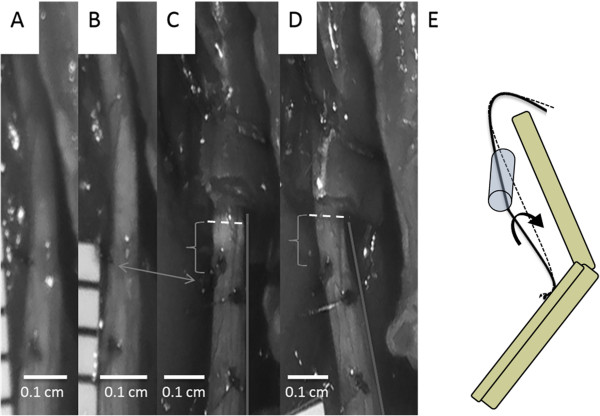
Images taken from a single strain measurement trial and a schematic of the system. Image definitions are as follows: (A) no cuff present, relaxed position; (B) no cuff present, extended position; (C) cuff present, relaxed position; (D) cuff present, extended position. Double headed arrow shows rotation of the nerve seen through the marker position (left side in (B), left to center in (C)). Brackets highlight differences in the impact of nerve contact with the cuff, and dotted lines highlight the cuff-nerve interface. (C) shows increased compression not present in (D). The line on the right of the nerve in (C) and (D) show alteration of the natural nerve path. (E) shows a schematic of the nerve movements seen in images (C) and (D).